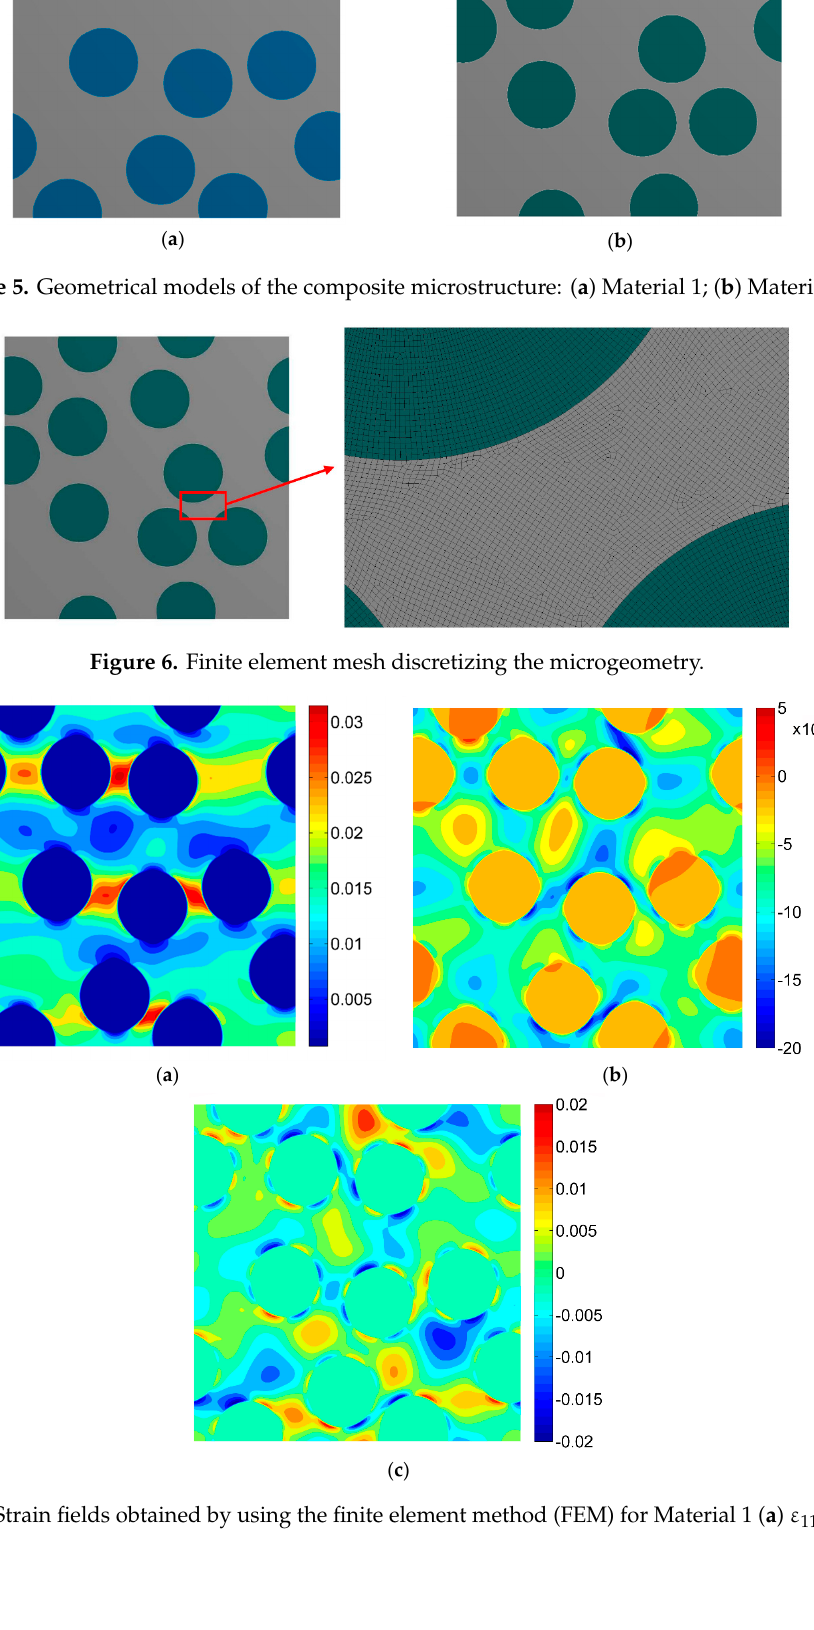
( b ) ( c ) Figure 8. Strain fields obtained by using the FEM for Material 2 ( a ) ε 11 ; ( b ) ε 22 ; ( c ) ε 12. The measurement of the transverse Poisson ratio (required as the regularization factor) was also simulated by using the FEM. In this case, a tensile test of the composite was modeled by assuming a three-dimensional representative volume element (RVE) whose geometry is presented in Figure 9.